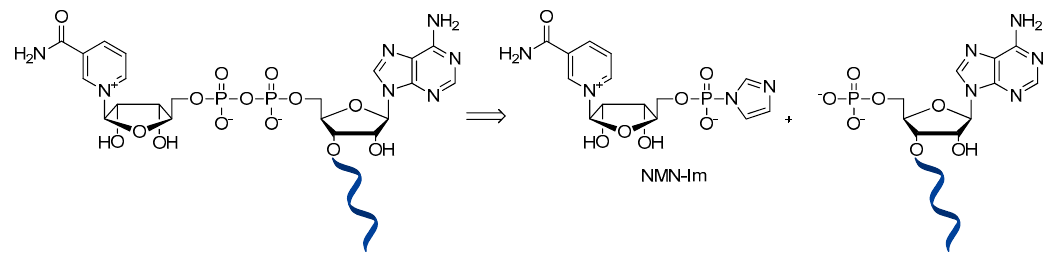
Figure 19. NAD-RNA synthesis strategy according to Hofer et al. [93].